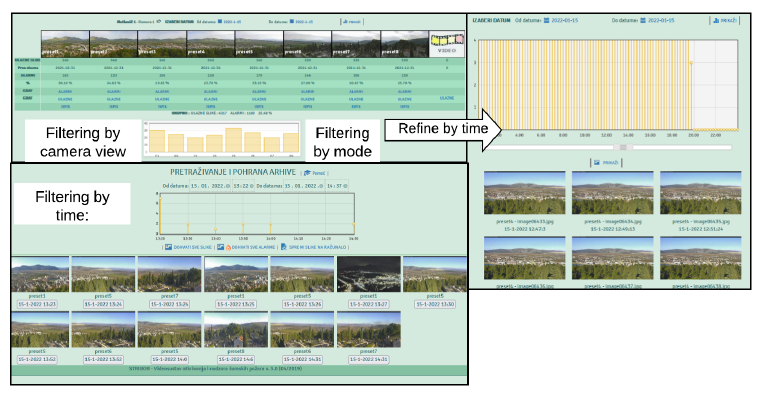
Figure 9. Intelligent forest fire monitoring and surveillance system archive search